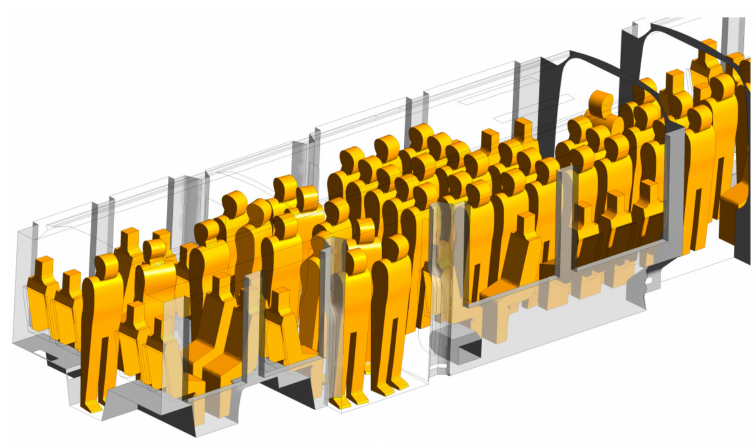
Figure 3. Passenger’s distribution in car C1.